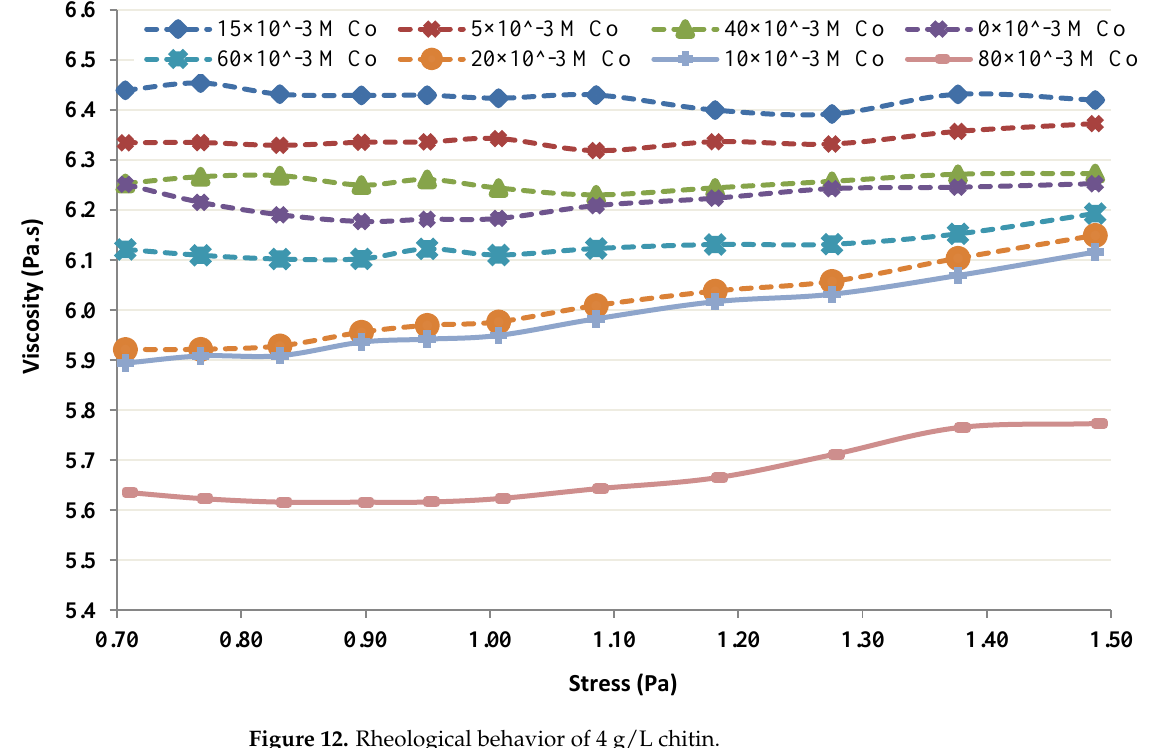
Figure 12. Rheological behavior of 4 g/L chitin. Figures 13 and 14 show Chitin’s (12 g/L) rheological behavior in the occurrence of 1 - 100 mM Co and Chitin’s (20 g/L) rheological behavior in the occurrence of Co (1 -100 mM), respectively. The control test in each trial was performed without Co. The control test for 12 g/L was Newtonian, and showed a shear-thinning behavior at a higher concentration (i.e., 20 g/L).